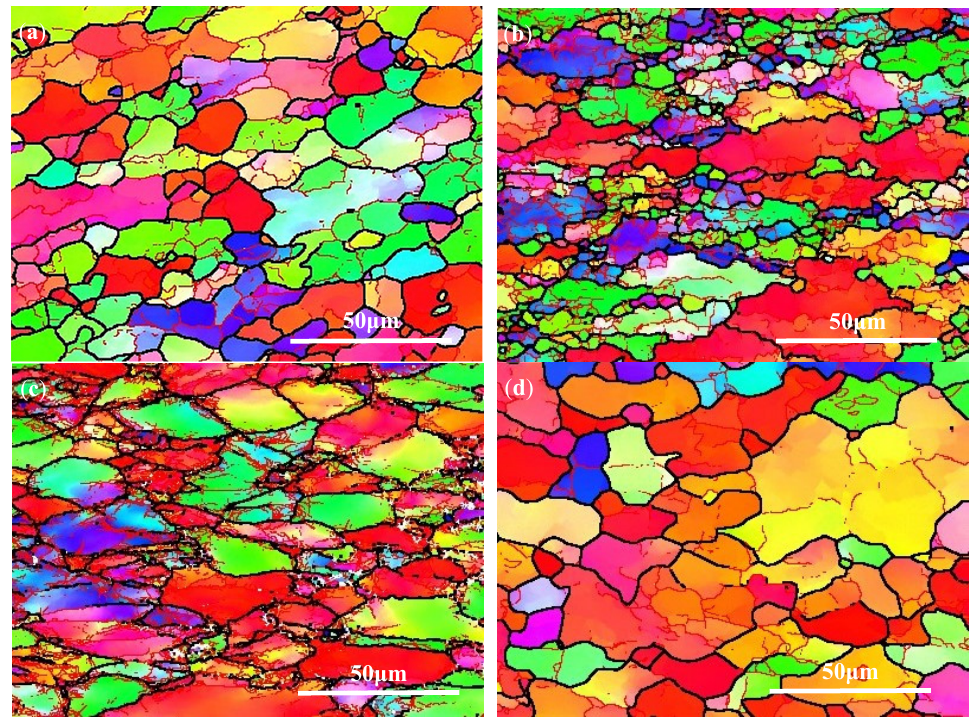
Figure 13. EBSD images of the deformed grains at β phase field: ( a ) 790 °C/0.001s − 1 , ( b ) 790 °C/0.1s − 1 , ( c ) 790 °C/10s − 1 , and ( d ) 820 °C/0.001s − 1 .